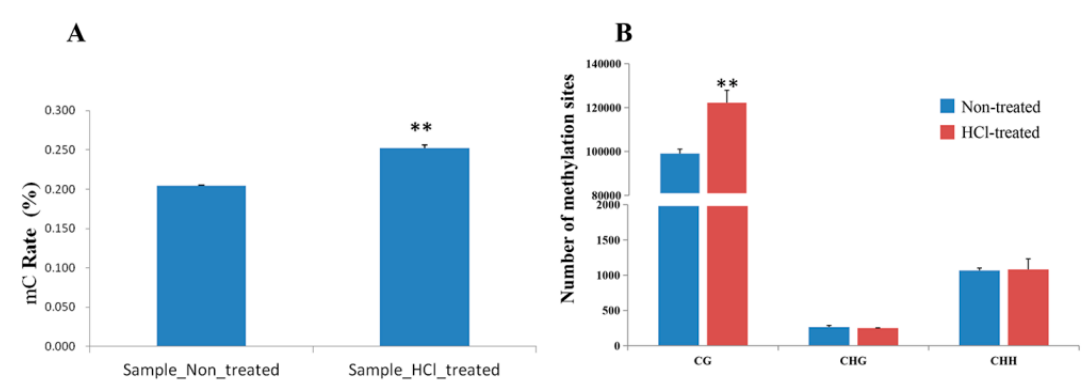
Figure 3. Analysis of methylation levels and methylation sites of di ff erent samples. Percentage methylation in di ff erent samples ( A ) and the numbers of di ff erent methylation sites ( B ). Three biological replicates comprised each sample type. Significant di ff erences are indicated by ** p < 0.01.